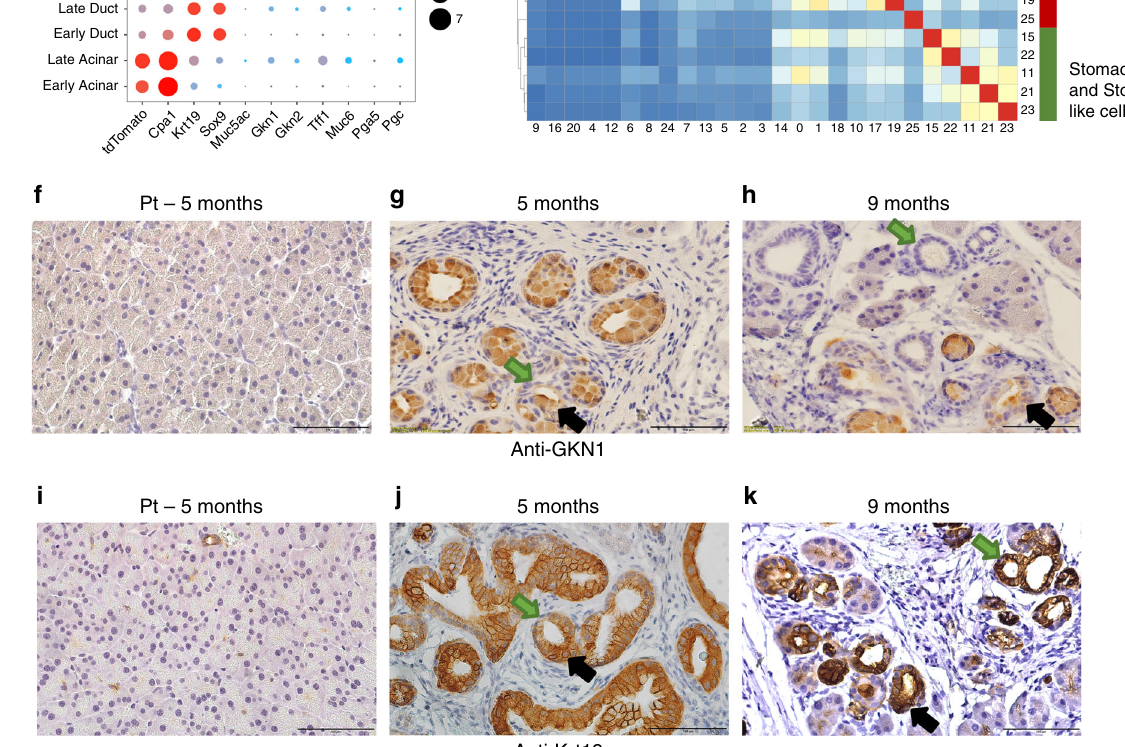
(Supplementary Fig. 5a – e). Clusters of stomach epithelial cells (expressing high levels of Epcam , Krt19 , and Sox9 ) were included in the analysis of acinar, ductal and metaplastic cells (Fig. 2a, b, clusters A_21 – 23). Cells in cluster A_22 expressed Gkn1 , Gkn2 , and Tff1 , and were therefore denoted as stomach pit cells (Fig. 3d). tic cells from pancreatic samples) and cluster A_22